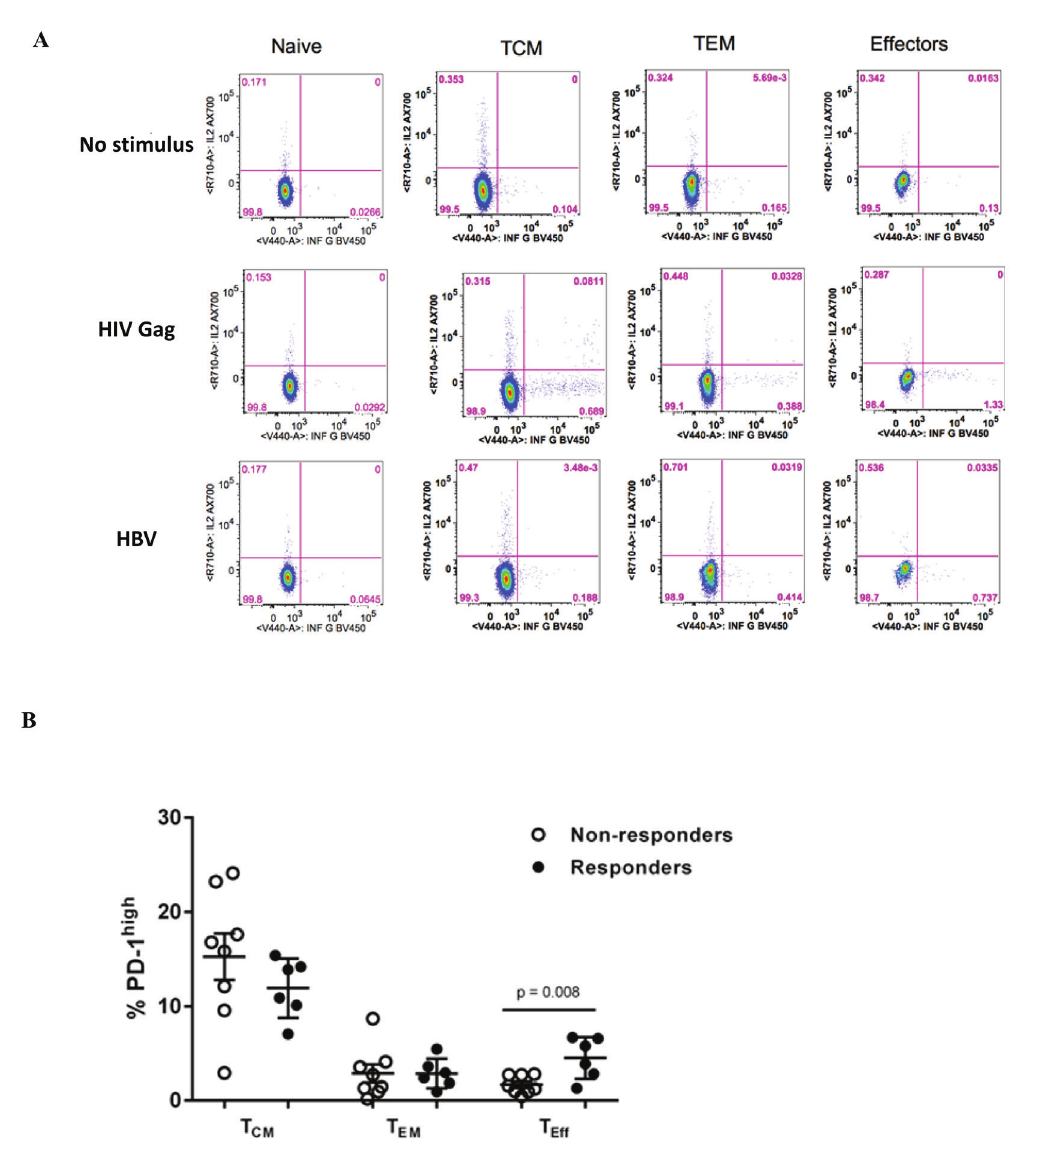
Supplementary Figure 4. (A) Pooled data showing the relative frequencies of pTfh cells with respect to expression of CCR6 and PD-1/ICOS pre- and post-vaccination, (B) Gating scheme for analysis of CD4 and CD8 T-cell function by intracellular cytokine staining using (ICS) after stimulation with pooled HIV Gag or hepatitis B surface antigen peptides, (C) expression of PD-1 in memory CD8 T-cell subsets in non-re- sponders and responders post-vaccination (scatterplot with mean and SEM, Mann-Whitney U